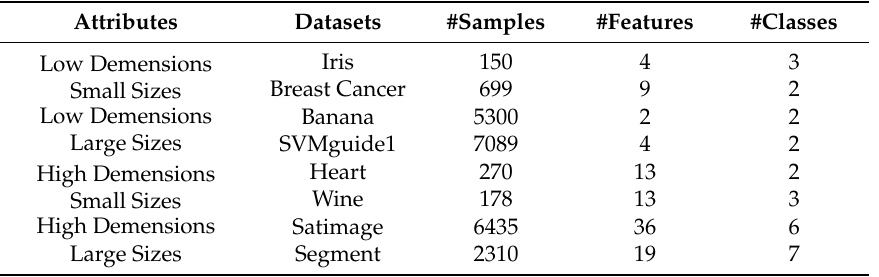
Table 1. Datasets’